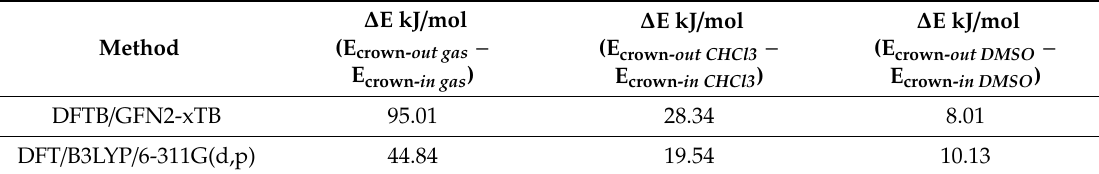
Table 1. The energy di ff erences, ∆ E (kJ / mol), for the optimised geometry of the crown- in and crown- out derivative 3 in the gaseous phase, CHCl 3 and DMSO, calculated by density functional theory (DFT) and DFTB methods.